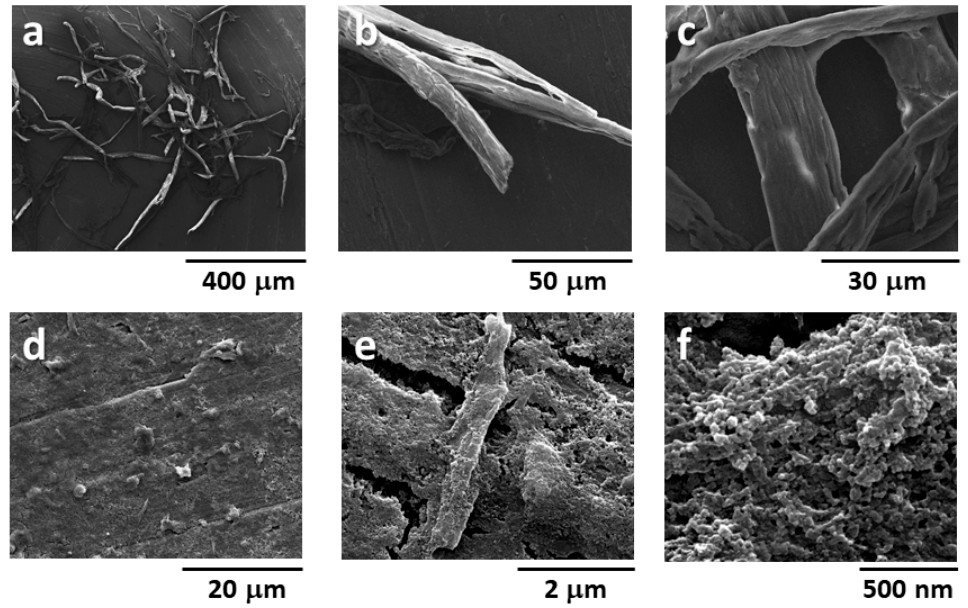
Figure 5. SEM images of C700-3h ( a – c ), BM60-3h ( d – f